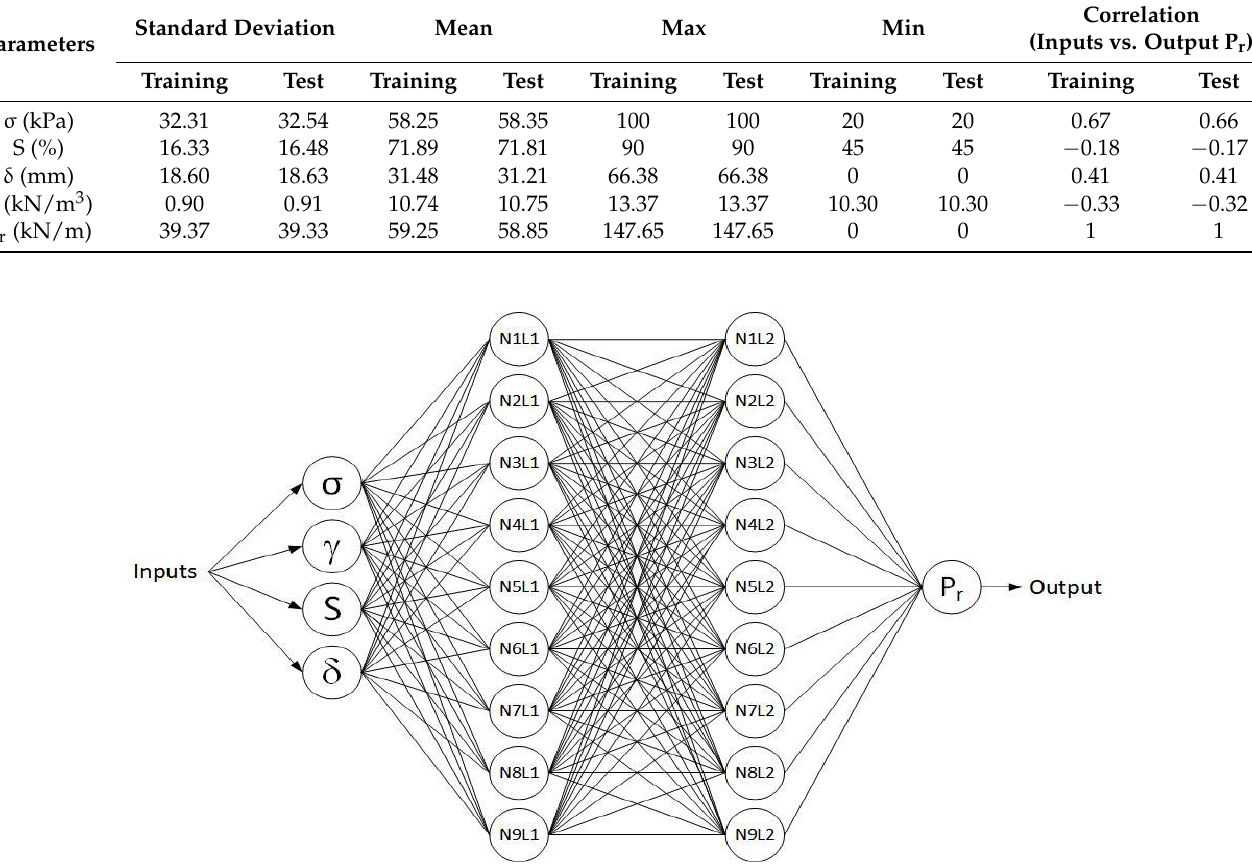
Figure 3. The machine learning architecture database consists of 61,775 measurements. Table 2. The statistical properties of the data.